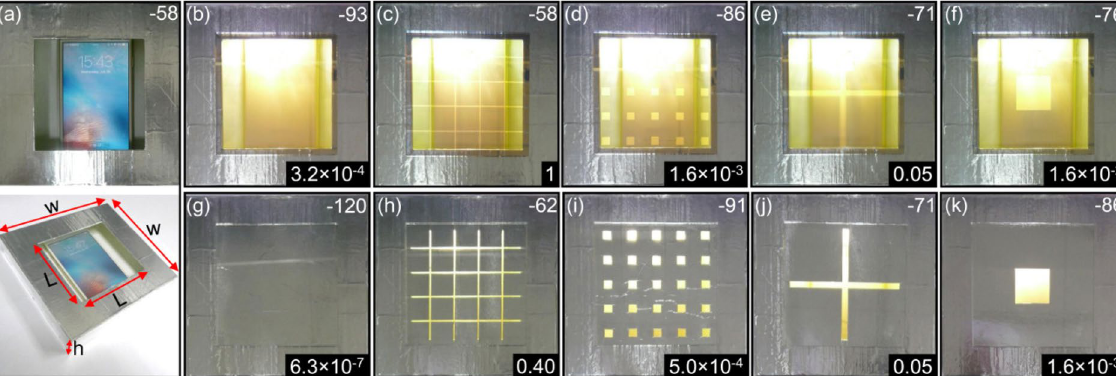
Figure 5. Examination of the signals received by a cell phone placed in a box with different windows. ( a ) The window is open. The top (bottom) panel is the top (3D) view of the box. ( b ) The window is covered with a piece of 1 mm-thick glass coated by 3-nm-thick TiO 2 , 1-nm-thick Au, 12-nm-thick Ag, 1-nm-thick Au and 100-nm- thick TiO 2 . ( c – f ) The same as ( b ) but with air in the metallic coatings, where the filling ratio of air is 0.1 ( i.e . the total area of air is fixed to be 8.1 cm 2 ). The air [metal] parts are connected in ( c , e ) [( d , f )]. The period a = 2 cm in ( c , d ). ( g – k ) The same as ( b – f ), but with the glass coated by 16 μ m-thick Al foil. The box is fabricated with PLA by using 3D printing and covered by 16 μ m-thick Al foil. The box has a wall thickness of 1 mm, w = 15 cm, h = 3 cm, and L = 9 cm. The numbers in the top right corners of the photos are the received power in unit of dBm, while the bottom ones are transmissions through the